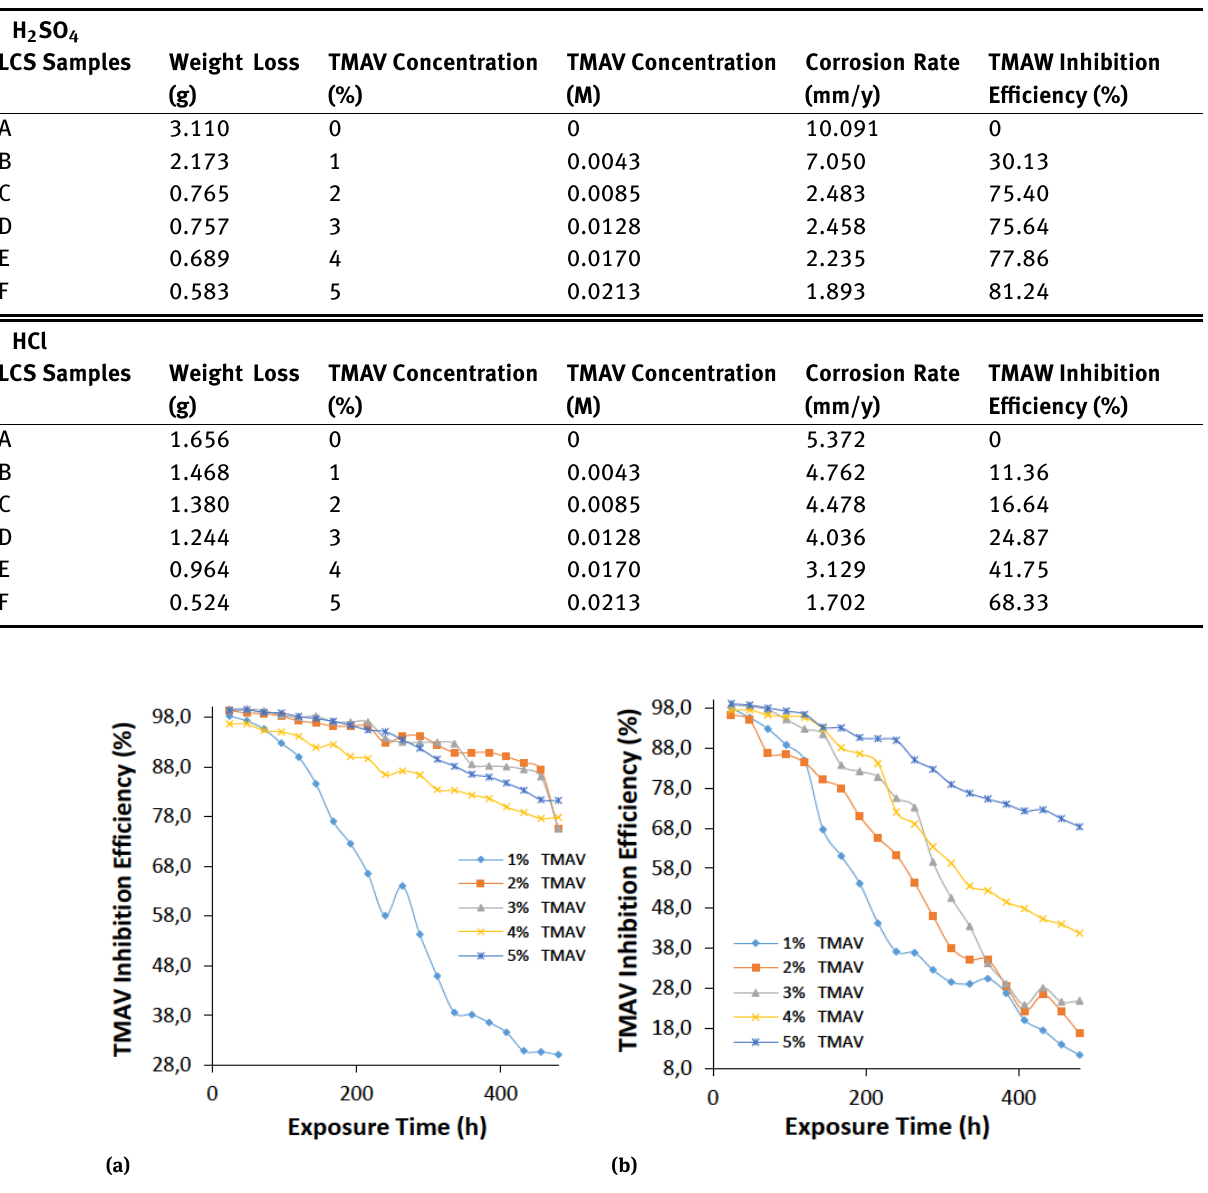
Figure 6: Plot of TMAV inhibition eflciency versus exposure time at 0% – 5% TMAV concentration in (a) H 2 SO 4 and (b)